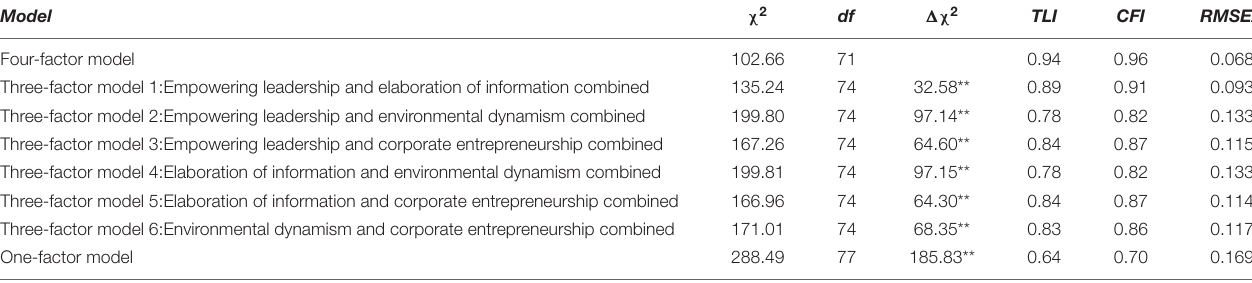
TABLE 1 | Results of confirmatory factor analysis for the measures of the variables studied. Model χ